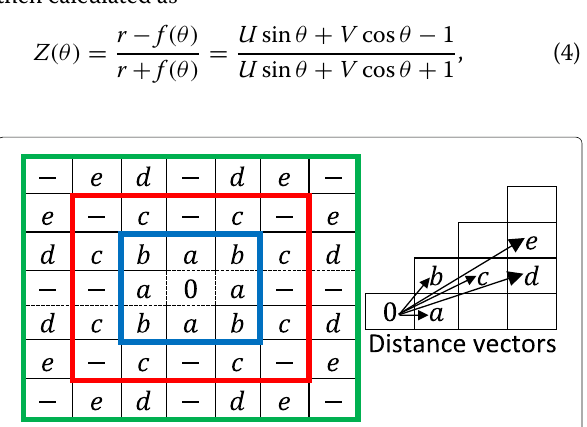
Fig. 1 Chamfer masks. From the center moving outwards, thick lines indicate 3 × 3, blue; 5 × 5, red; and 7 × 7, green. Forward and backward masks are obtained by splitting the mask along the dotted